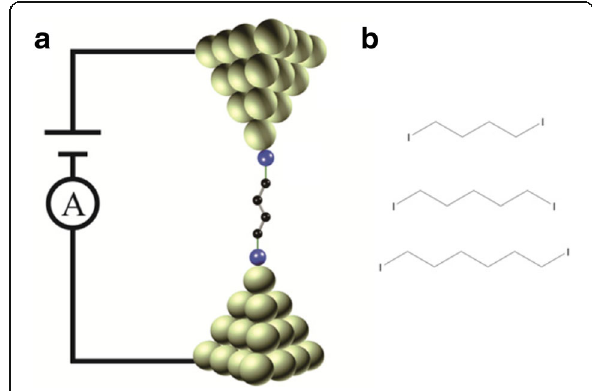
Fig. 1 Schematic diagram of scanning tunneling microscopy break junction (STM-BJ) and molecular structures. a Schematic of the STM-BJ with molecular junction. b Molecular structures of